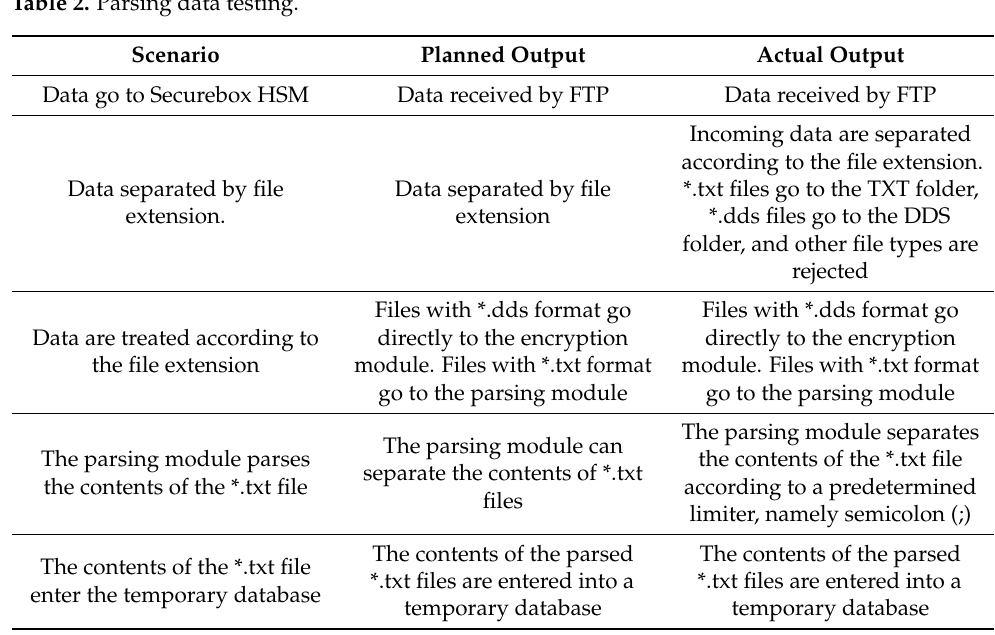
Table 2. Parsing data